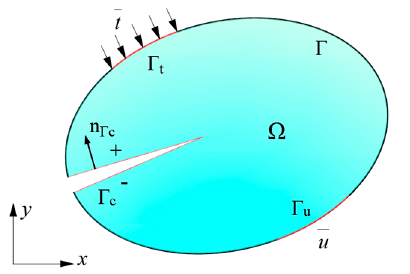
Figure 1. A body in a state of elastostatic Figure 1 . A body in a state of elastostatic equilibrium.